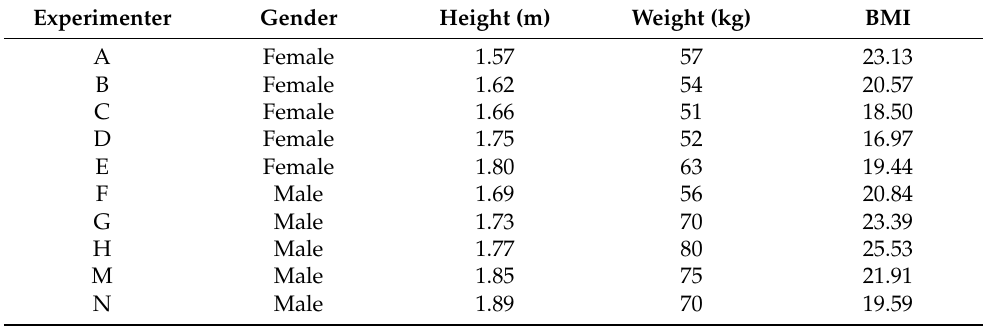
Table 1. Body characteristics of the